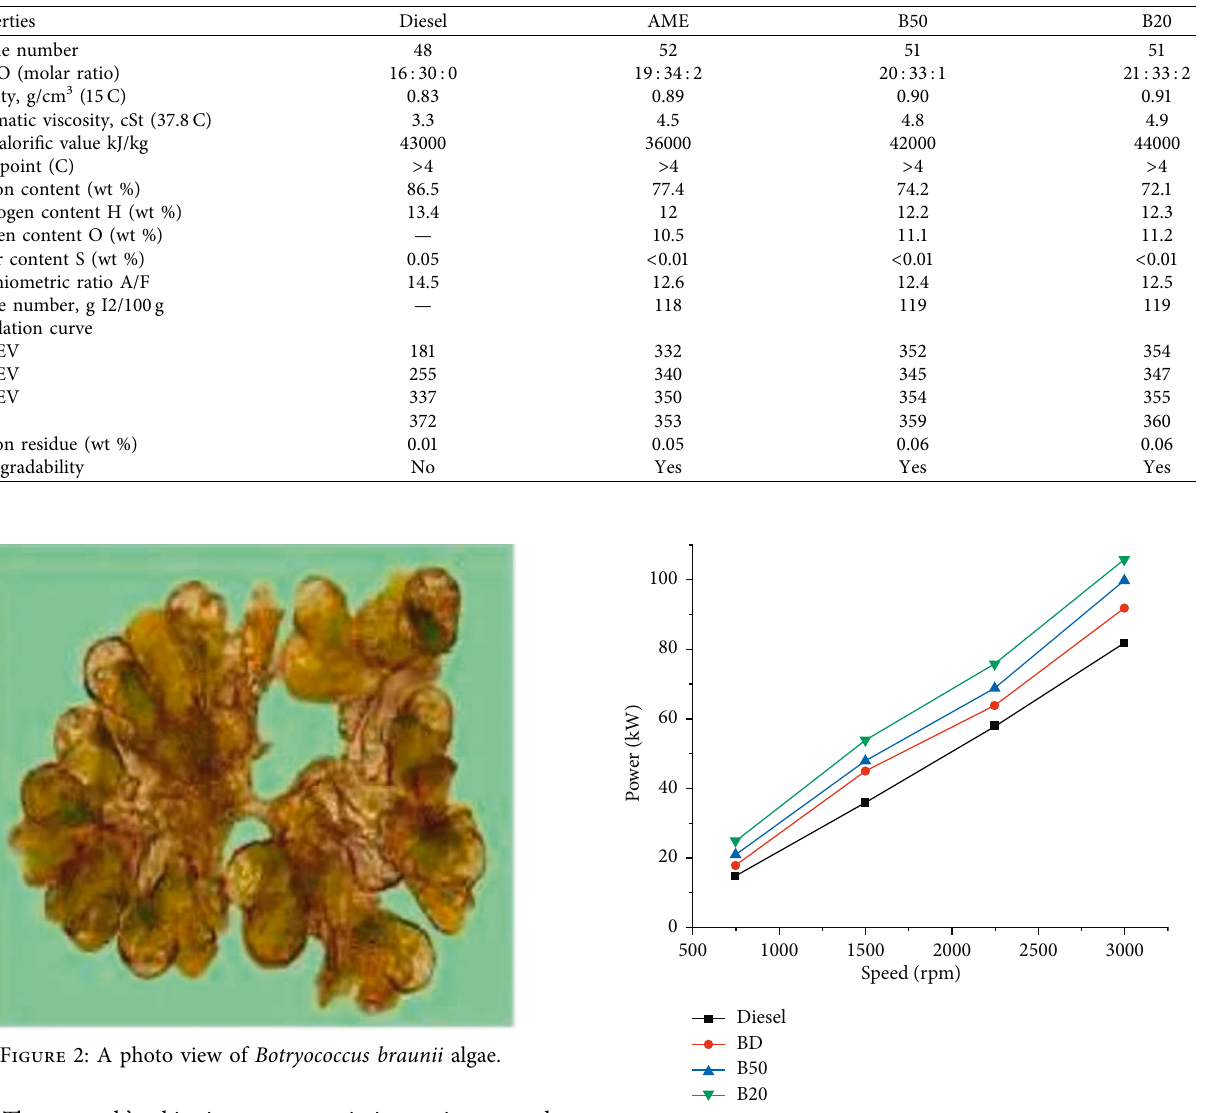
Figure 3: Power vs